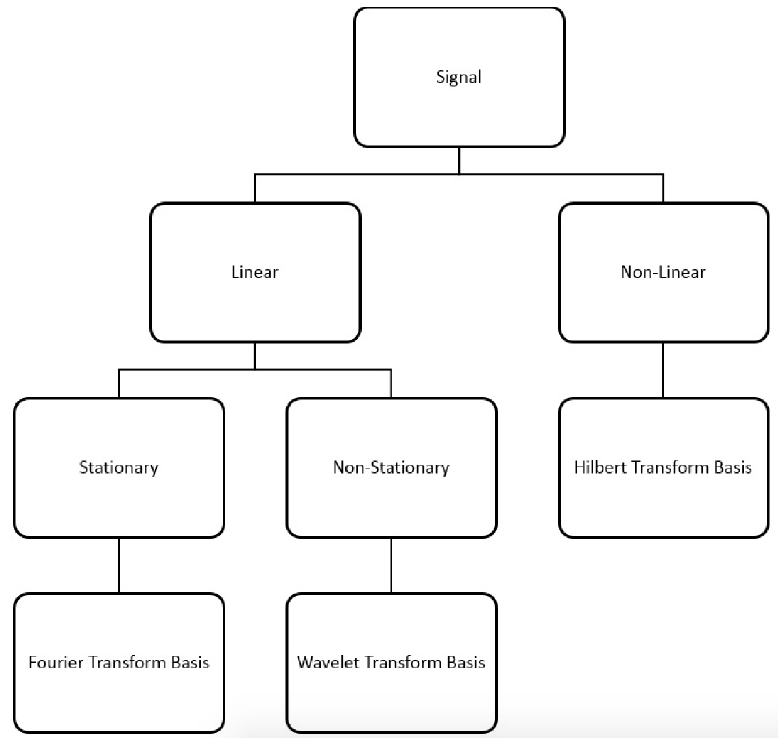
Figure 1. Signal classification and appropriate transform